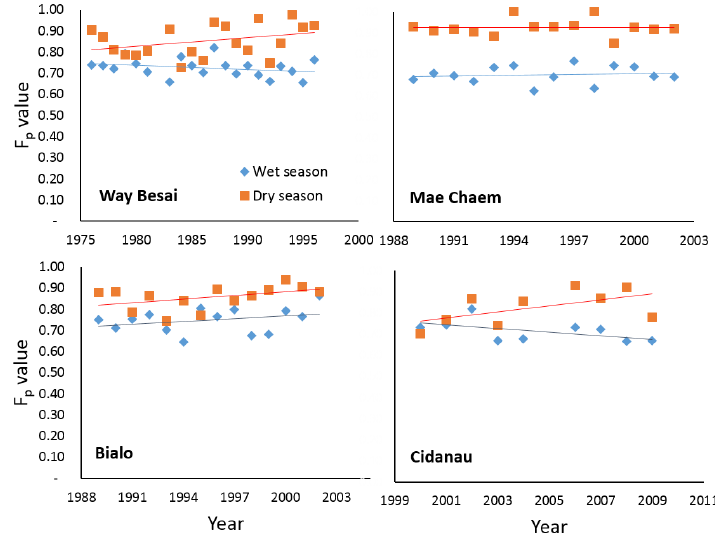
Figure 2. Flow persistence ( F p ) estimates derived from measurements in four Southeast Asian watersheds, separately for the wettest and driest 3-month periods of the year.